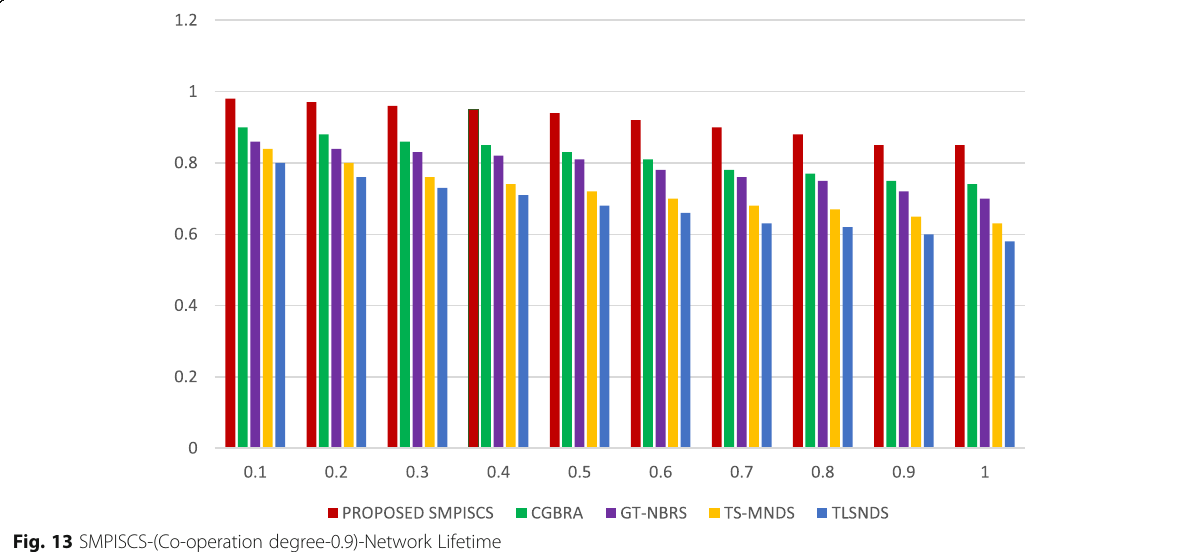
Fig. 13 SMPISCS-(Co-operation degree-0.9)-Network